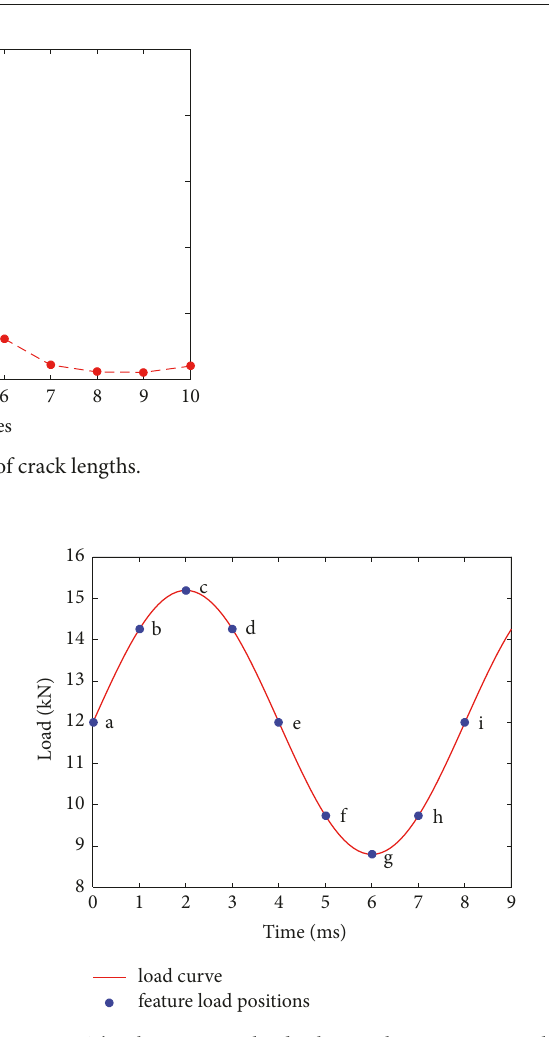
Figure 10: Comparison of crack tip positions measured by the two methods.